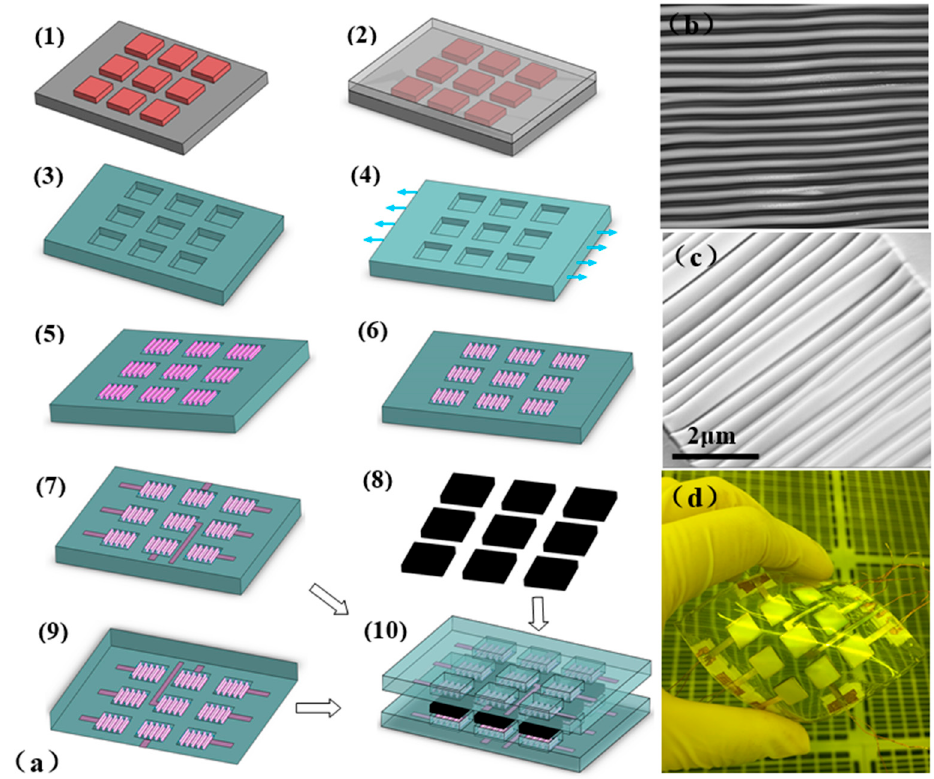
Figure 1. ( a ) Schematic diagrams of the fabrication procedure for the flexible pressure sensor: (1) SU-8 mold; (2) Polydimethylsiloxane (PDMS) casting; (3) PDMS mold; (4) Pre-strain PDMS; (5) Pre-strain relax after O 2 plasma treatment; (6) Sodium dodecyl sulfate (SDS) surface functionalization; (7) Ag wrinkled electrodes on the PDMS substrate after Ag sputtering; (8) Carbon nanotubes (CNTs)/PDMS elastomer dielectric layer; (9) Ag wrinkled electrodes on the PDMS substrate; (10) Flexible pressure sensor; ( b ) Laser confocal image of the electrode pattern; ( c ) Cross-section of the fabricated electrode from an SEM image; ( d ) digital image of a typical flexible pressure sensor with 3 × 3 detecting units.